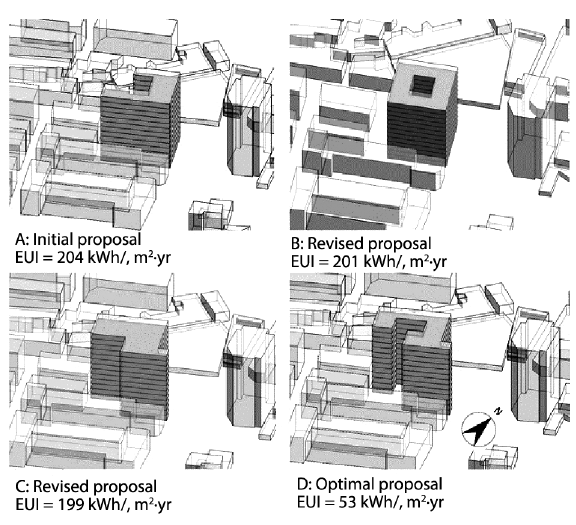
Figure 16. Continuing optimizing